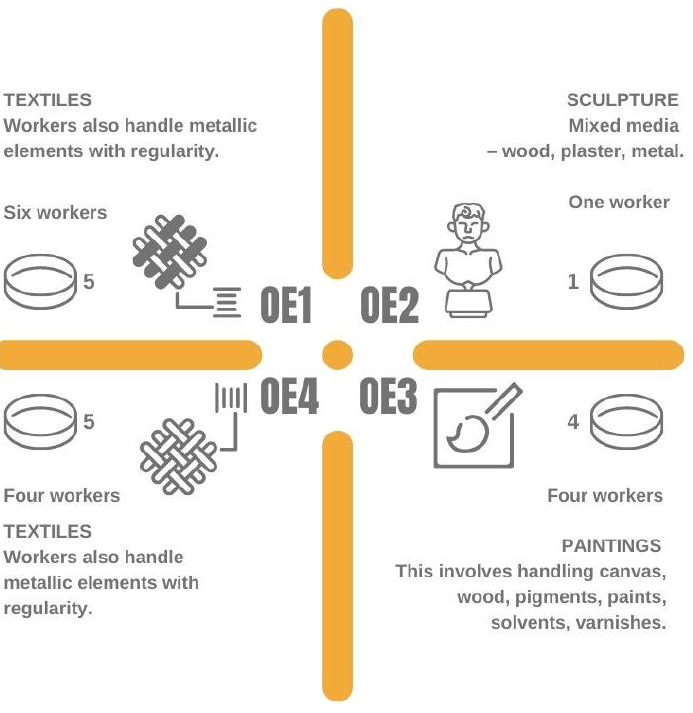
Figure 1. Sampling locations, OE1 and OE4 for textiles, OE2 for sculpture and OE3 for the painting’s restoration studio.